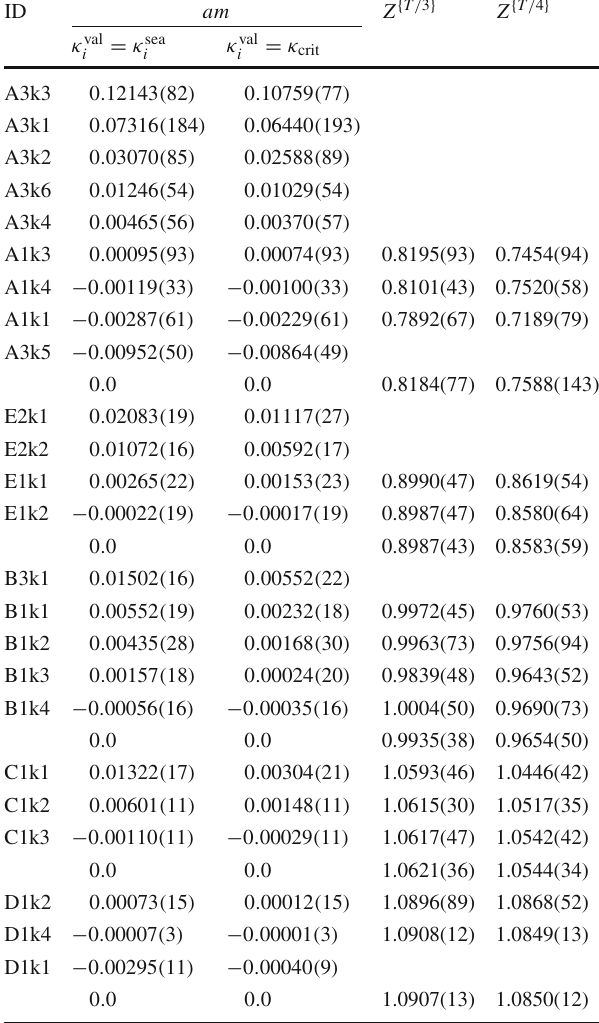
Table2 Foreachensemble,identifiedinthefirstcolumnbyanIDlabel, we list our results for the PCAC mass am for simulations with κ val = κ sea (second column) and κ sea (cid:3)= κ val = κ crit (third column). The last two columns contain Z results obtained from the Ward identity (3.5). The final results are those extrapolated to the chiral limit at each β = 6 / g 2 (last line of each data grouping). The labels Z { T / 3 } and Z { T / 4 } 0 refer to different choices of time slices with operator insertions in the correlation functions (see text for